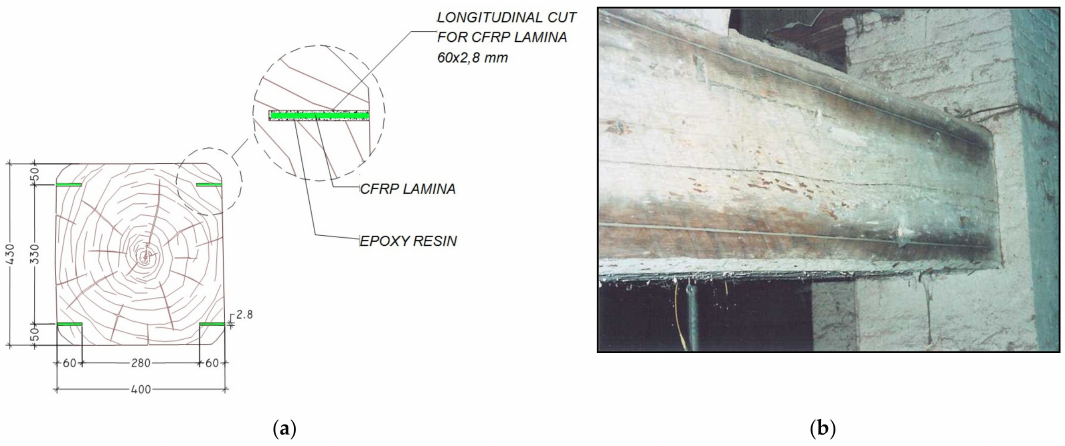
Figure 12. ( a ) The beam section reinforced with CFRP laminae; ( b ) a picture of the beam after the reinforcement (dimensions in